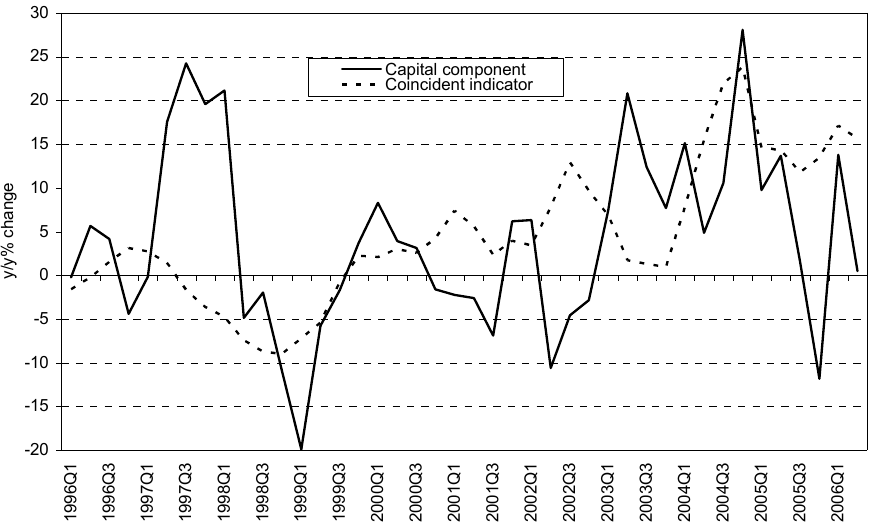
FIGURE 2: Capital component of the financial